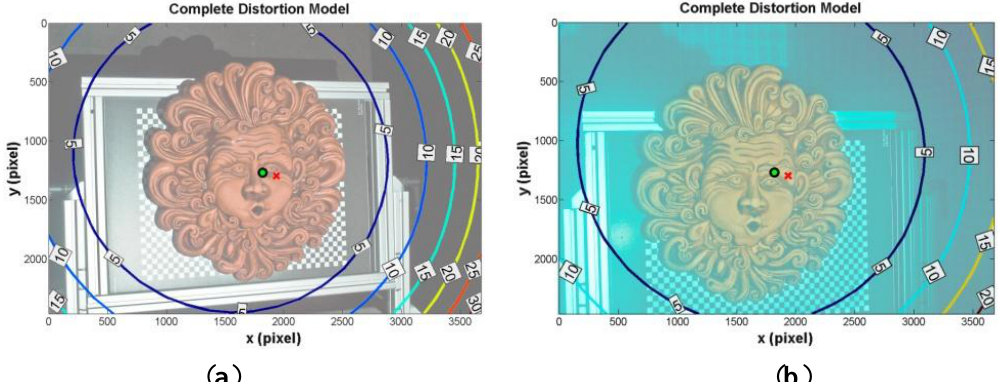
Figure 7. Complete distortion model (radial plus tangential distortions) in air and clear water. The cross and the circle indicate the image centre and the principal point, respectively. The contours represent the optical distortions values (in pixel), ( a ) Air; ( b )